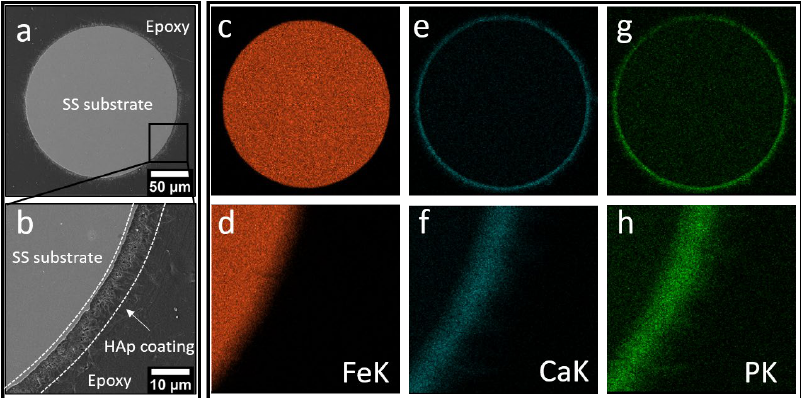
Figure 6. SEM micrographs and EDS analysis of HAp coatings synthesized under − 1.5 V on a 304 SS woven lattice. Cross-sectional morphologies: ( a , b ); elemental distribution of HAp coating: Iron: ( c , d ); calcium: ( e , f ); phosphorus: ( g , h ).